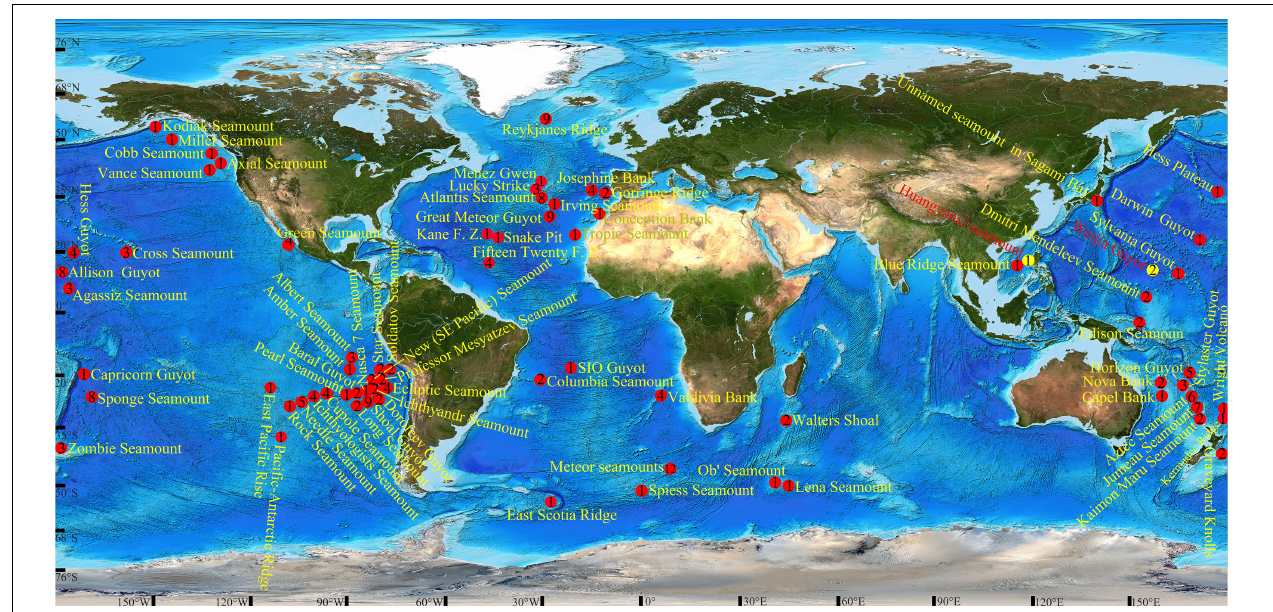
FIGURE 1 | Locations of barnacles distributed in seamounts. Yellow circles indicate sites from which the new species were collected; Arabic numerals in circles indicate the number of barnacle species in the seamounts.